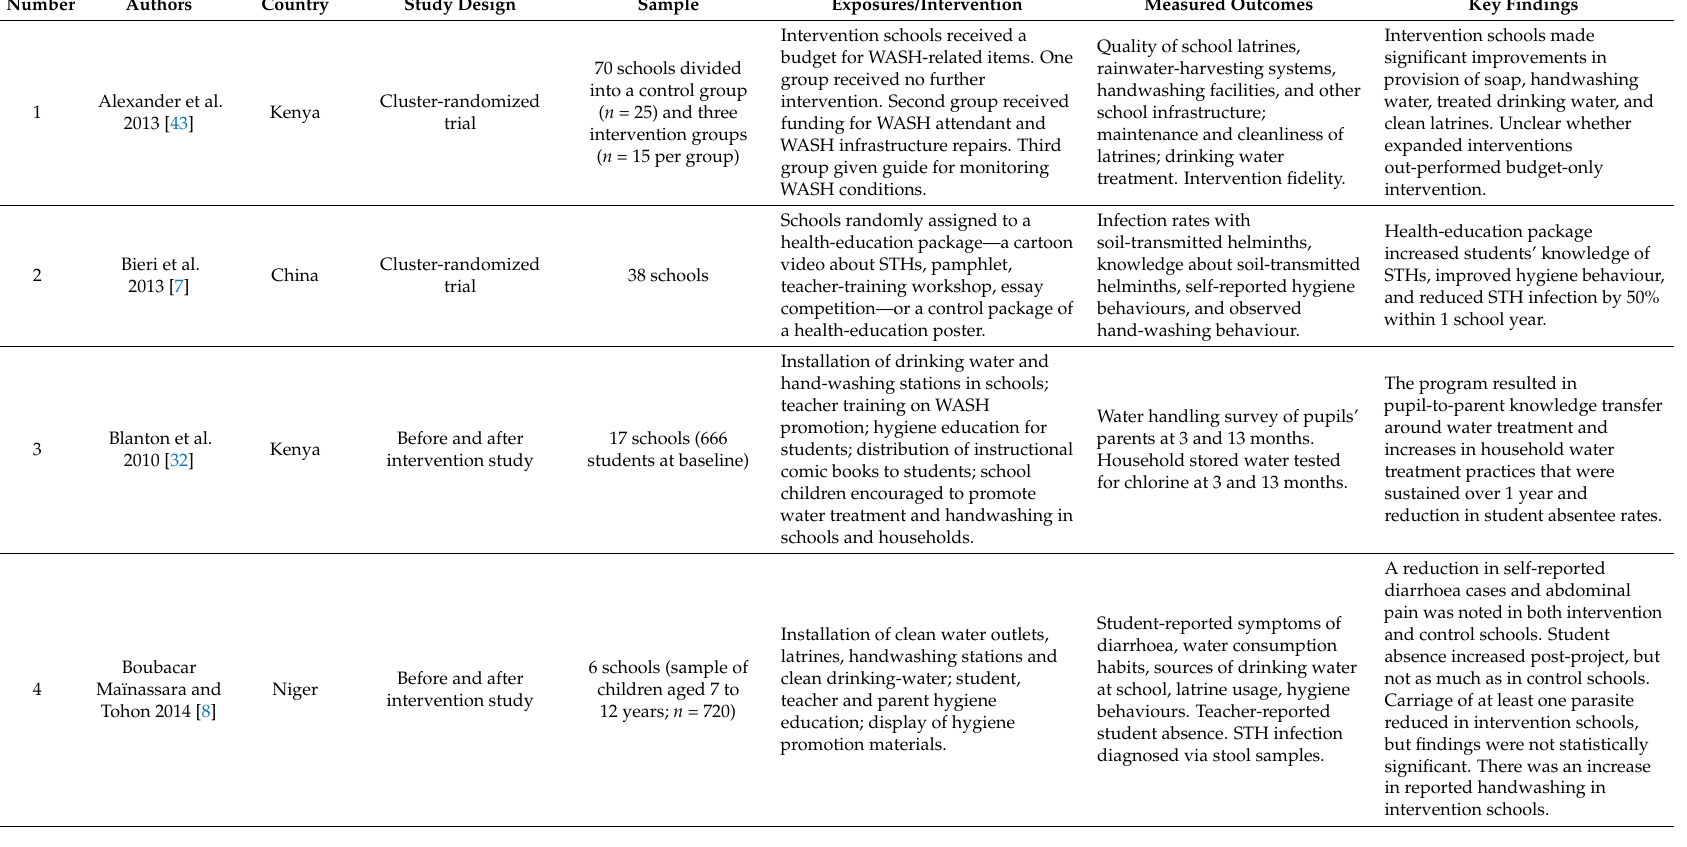
Table 2. Published evaluations of WASH in schools in low-income